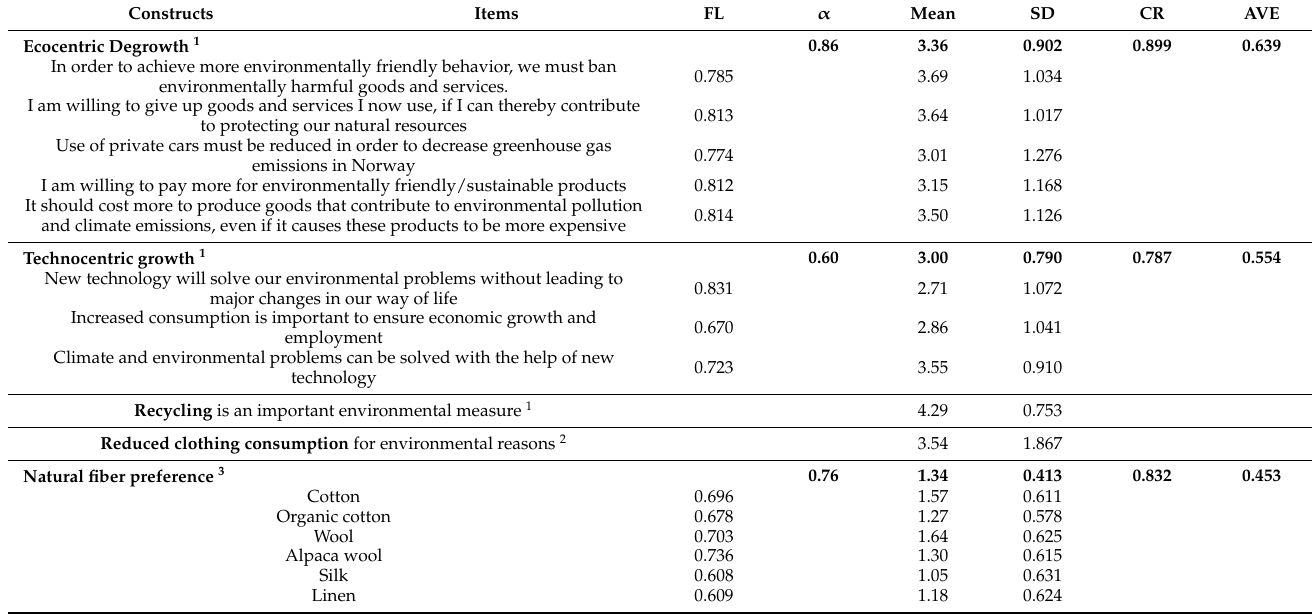
Table 2. Principal component factor analysis and items for analysis (FL = factor loadings, mean = mean value of the items and constructs, SD = standard deviation, α = Cronbach’s alpha, CR = composite reliability, AVE = average variance